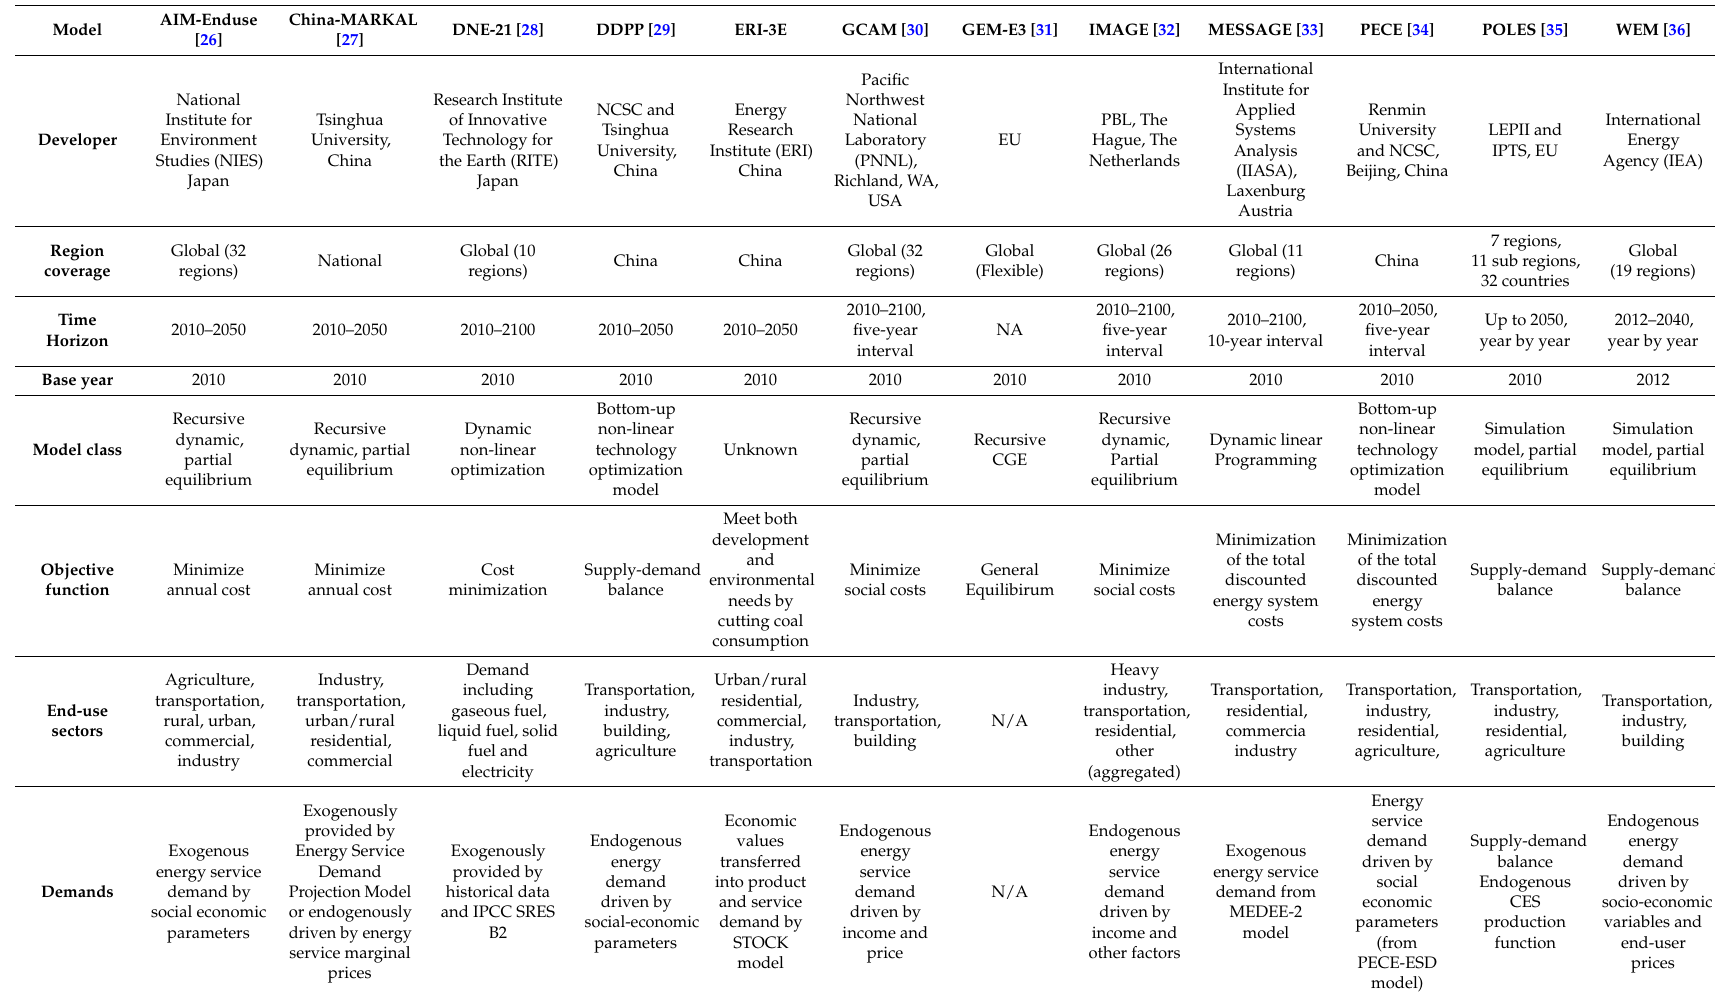
Table A1. Major features of models surveyed in this study.